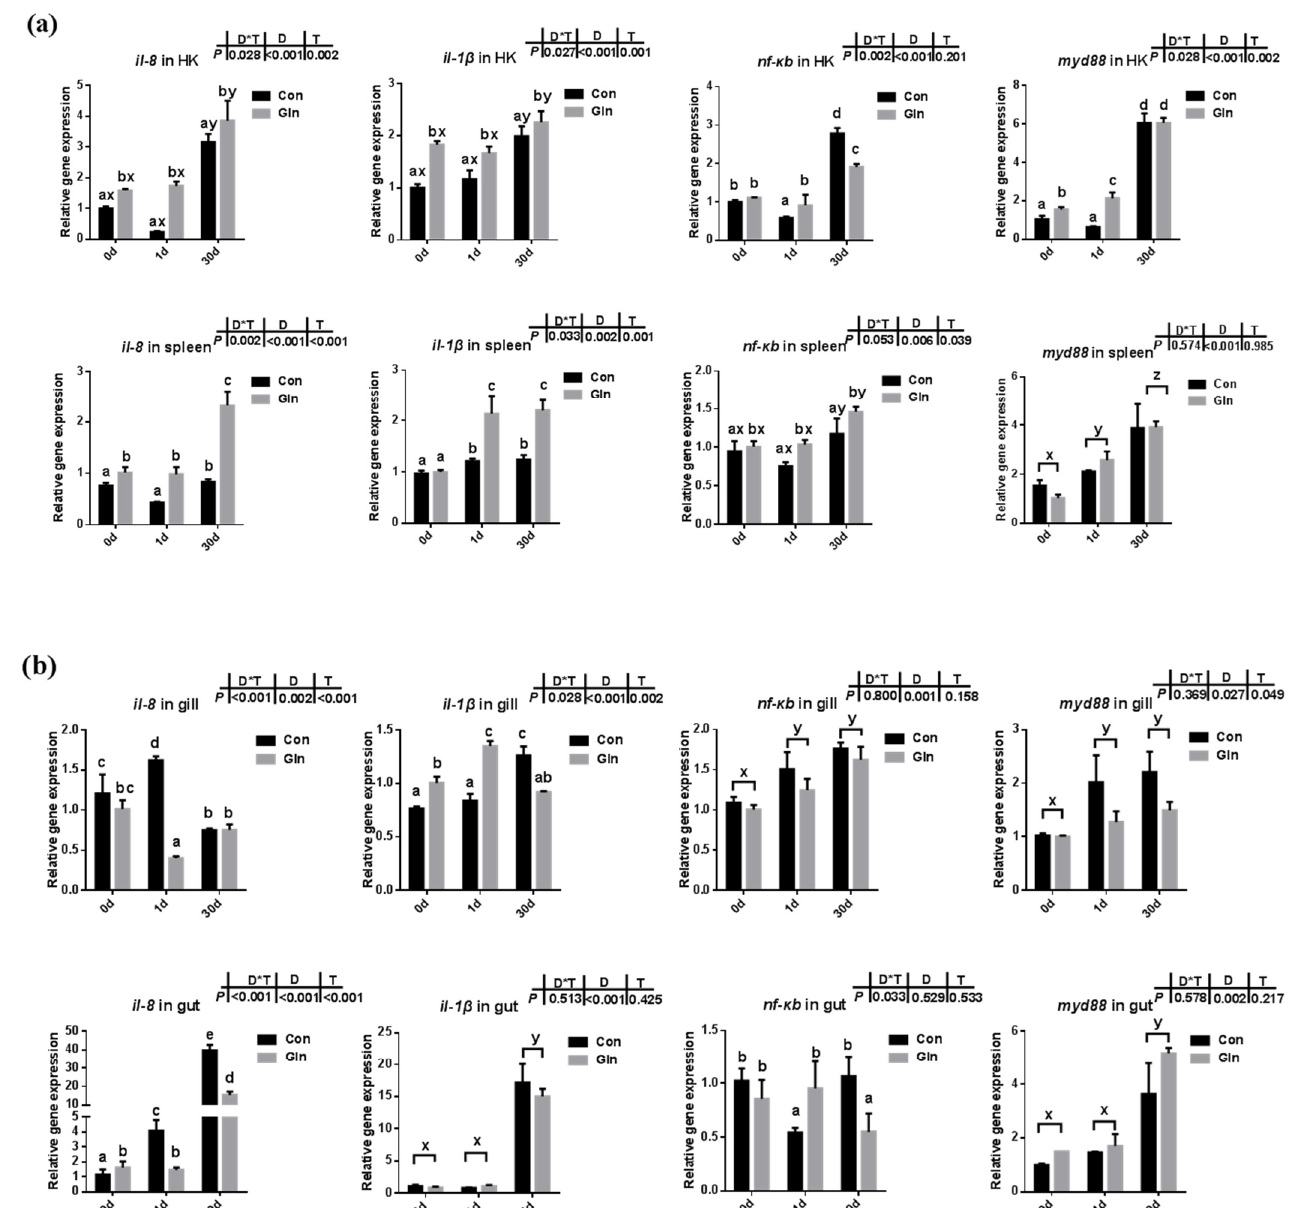
Figure 1. The effects of dietary glutamine on the inflammatory responses in systematic and mucosal immune tissues of yellow catfish during F. columnare infection. The relative mRNA expression levels of pro-inflammatory cytokines ( il-8 , il-1 β ) and genes involved in NF- κ B signaling pathway ( nf- κ b , myd88 ) in the head kidney, spleen ( a ), and gill, gut ( b ) of yellow catfish fed with control diet (Con) and glutamine supplementation diet (Gln) at 0 d, 1 d and 30 d after F. columnare infection. All data was analyzed with two-way ANOVA and data are means ± SD ( n = 3). When significant D*T were observed ( p < 0.05), data were analyzed by one-way ANOVA followed by Tukey’s multiple range tests to inspect differences among all the data, with “a–e” to indicate the significant difference. When the significance is only with the main effects of D or T, “a–e” and “x–z” were labeled to indicate the significant difference among groups in D or T, respectively.